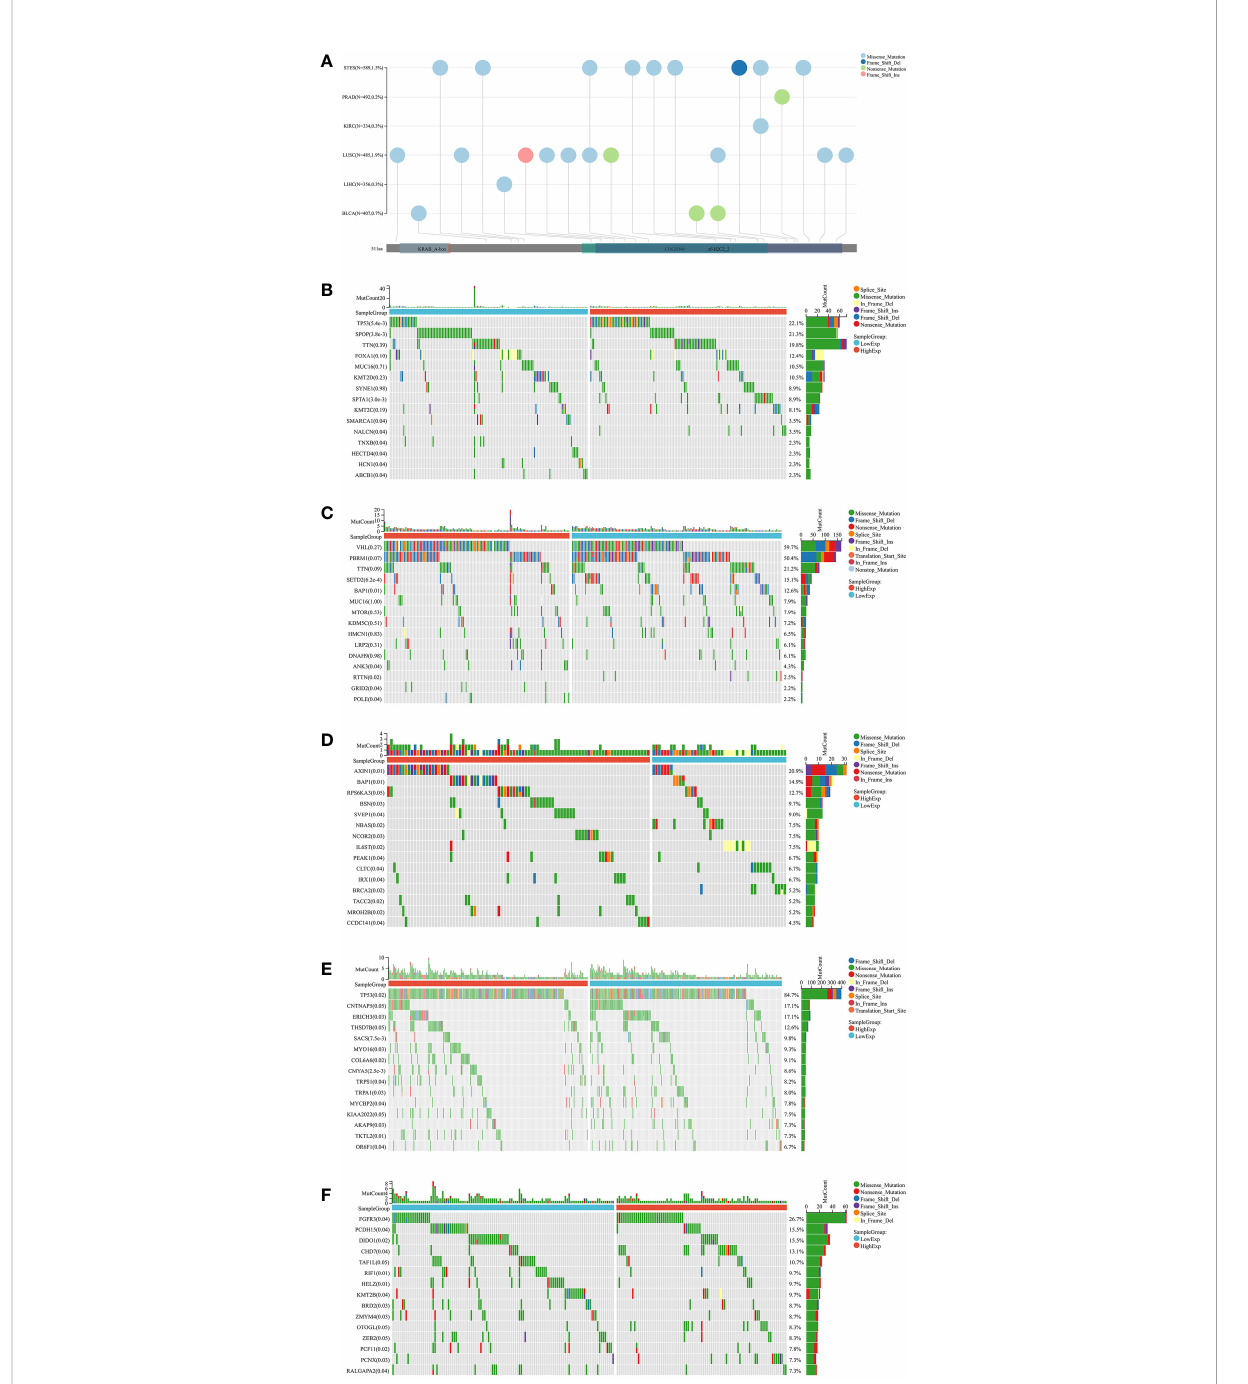
FIGURE 6 Mutation landscapes analysis of ZNF419. (A) mutation landscapes of ZNF419 for STES, PRAD, KIRC, LUSC, LIHC, and BLCA; (B) the top 15 mutation genes between high and low-expression of ZNF419 in PRAD patients; (C) the top 15 mutation genes between high and low- expression of ZNF419 in KIRC patients; (D) the top 15 mutation genes between high and low-expression of ZNF419 in LIHC patients; (E) the top 15 mutation genes between high and low-expression of ZNF419 in LUSC patients; (F) the top 15 mutation genes between high and low- expression of ZNF419 in BLCA patients. STES, stomach and esophageal carcinoma; PRAD, prostate adenocarcinoma; KIRC, kidney renal clear cell carcinoma; LUSC, lung squamous cell carcinoma; LIHC, liver hepatocellular carcinoma; BLCA, bladder urothelial